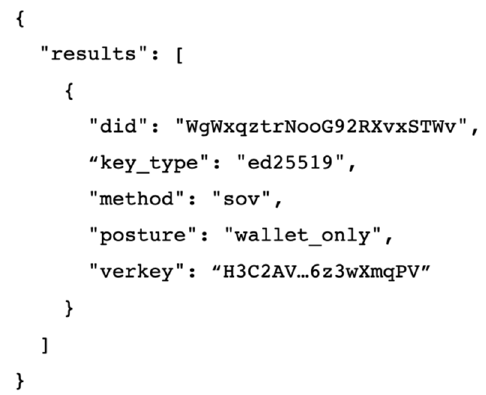
Figure 12. The example of the DID of a researcher.